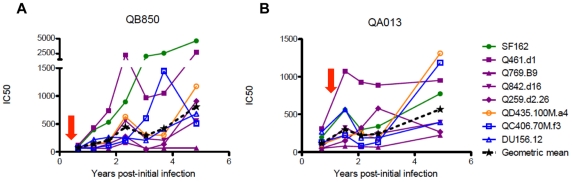
Elite neutralizers QB850 and QA013 develop breadth within 1 year following SI.The kinetics of the NAb responses for QB850 (A) and QA013 (B) are shown versus years post-initial infection. Viruses of the same subtype are shown with the same line color. Geometric mean IC50s for the entire 8-virus panel are shown in the dashed black lines. The approximate time of SI, calculated as described in Figure 1, is indicated by the corresponding red arrows for each individual.